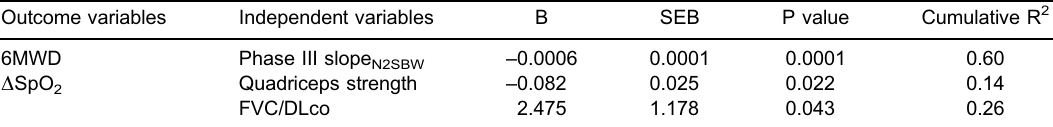
Table 3. Independent linear models for variables of the 6-min walk test using lung function and peripheral muscle parameters. Outcome